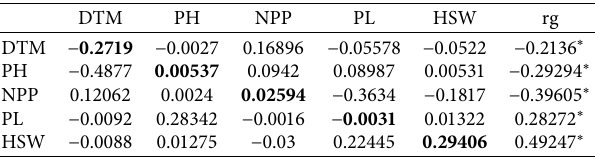
Table 6: Genotypic direct and indirect efects of diferent traits on grain yield. DTM